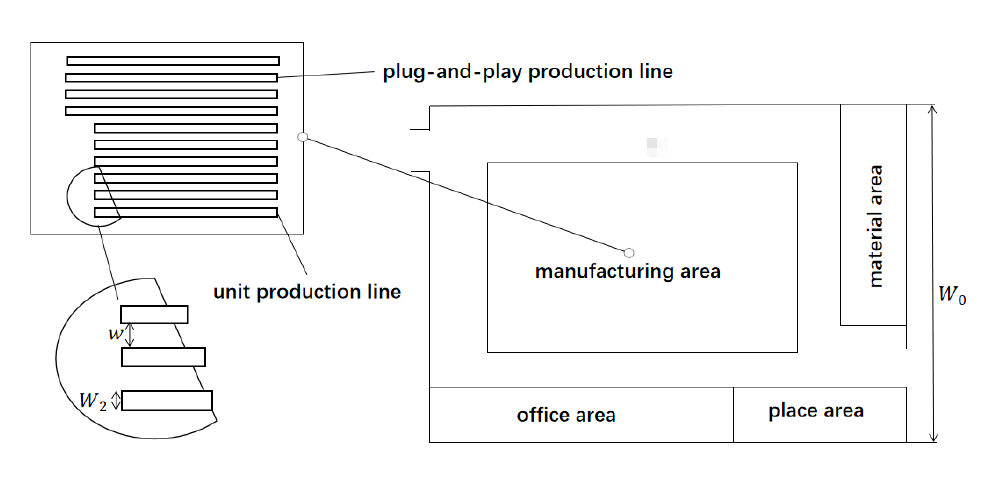
Figure 5. The layout of the whole hybrid